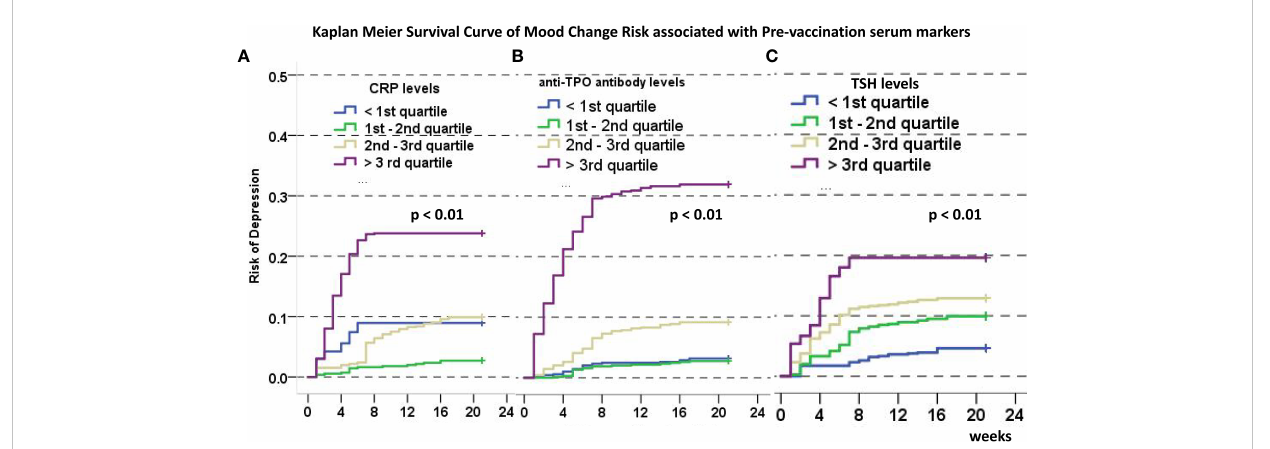
FIGURE 2 Kaplan-Meier Curve of disease-free survival (de fi ned as time to mood changes) associated with CRP (A) , anti-TPO (B) , and TSH (C) levels categorized by the 25th, 50th, and 75th quartile. In all images, a higher ladder of marker categories predict higher incidence of disease-free